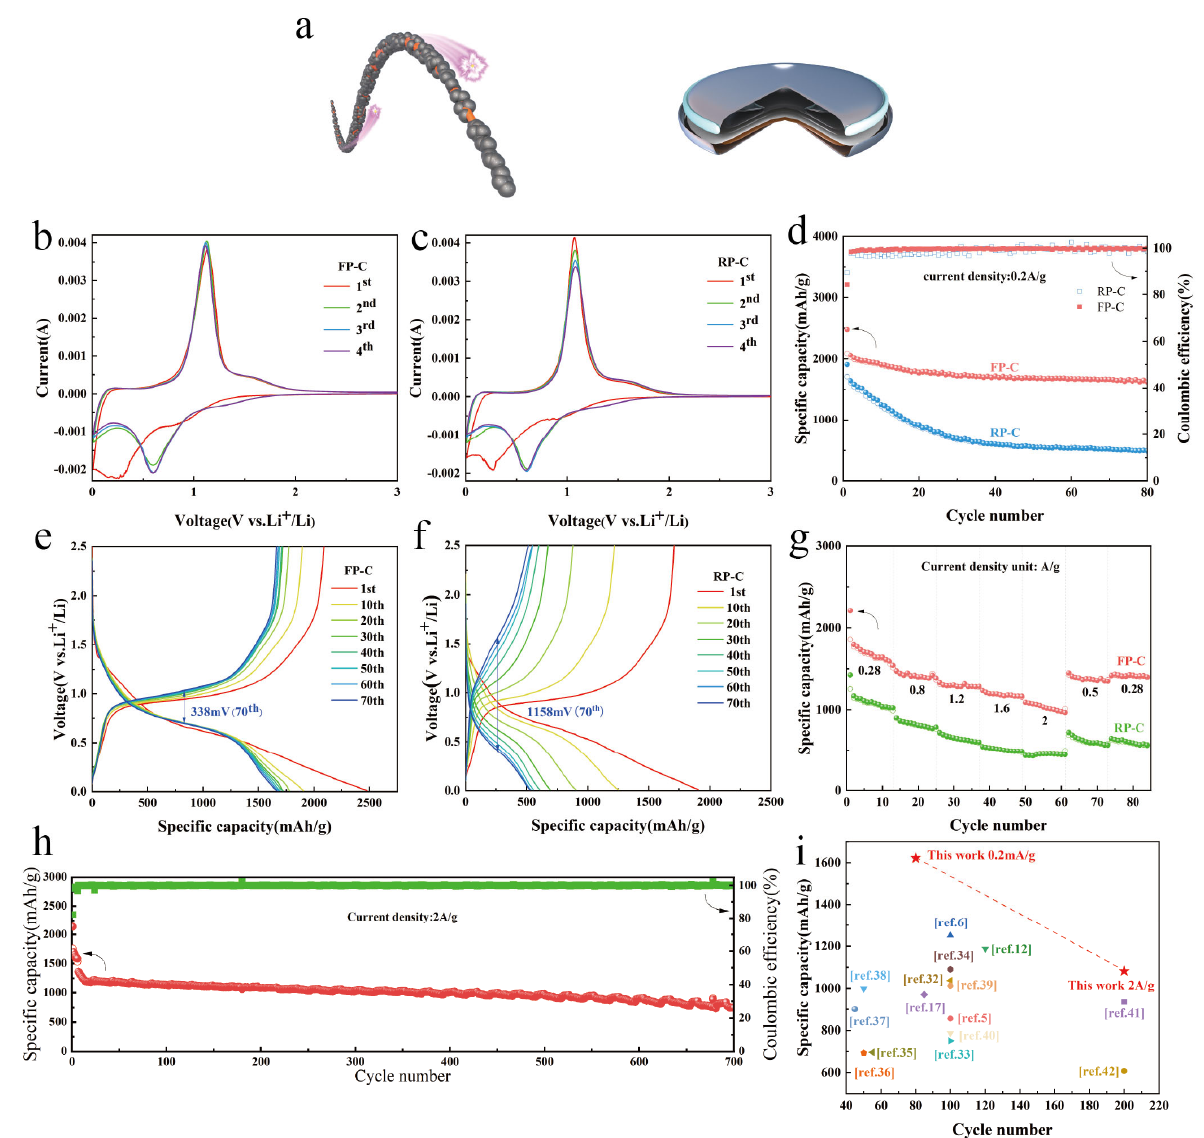
Figure 3. Electrochemical performance of RP-C and FP-C electrodes for LIBs. ( a ) Schematic illustration of the FP-C and button cell. ( b , c ) CV of the FP-C and RP-C anodes with a scan rate of 0.2 mV/s between 0.01 and 3.0 V vs. Li + /Li. Cycling stability of FP-C and RP-C anodes for 80 cycles at 0.2 A/g ( d ) and the corresponding voltage profiles of FP-C ( e ) and RP-C ( f ). ( g ) Rate performance of FP-C and RP-C anodes at the varied rate from 0.28 A/g to 2 A/g. ( h ) Capacity and coulombic efficiency during cycling of the FP-C anode at 2 A/g after 5 initial cycles at a low current density of 0.2 A/g. Overall capacity and cycling stability compared with other reported RP- and BP-based anode materials ( i ). The data and current density of each material are summarized in Table S1 (Supporting